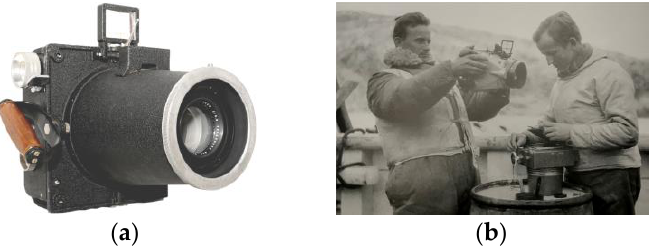
Figure 15. ( a ) The Fairchild F-8 camera, ( b ) a historical photo with the pilot and photographer in the book. The photographer holding a Fairchild F-8 camera [7]. book. The photographer holding a Fairchild F-8 camera